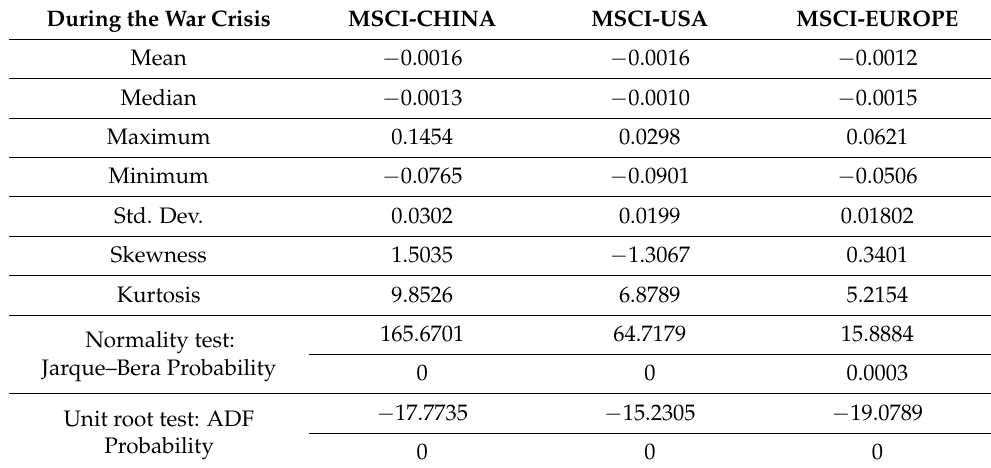
Table 3. Descriptive statistics and stationarity results (during the war